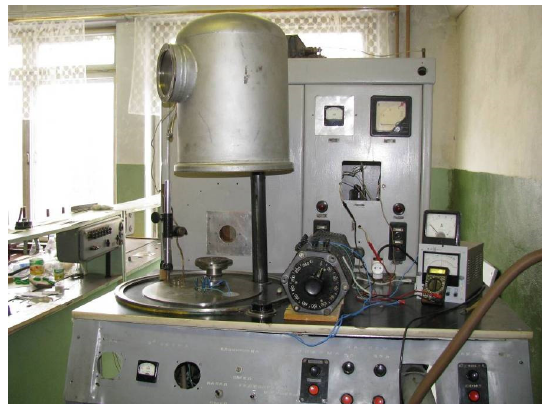
Figure 3. Appearance of the experimental RF plasma unit .